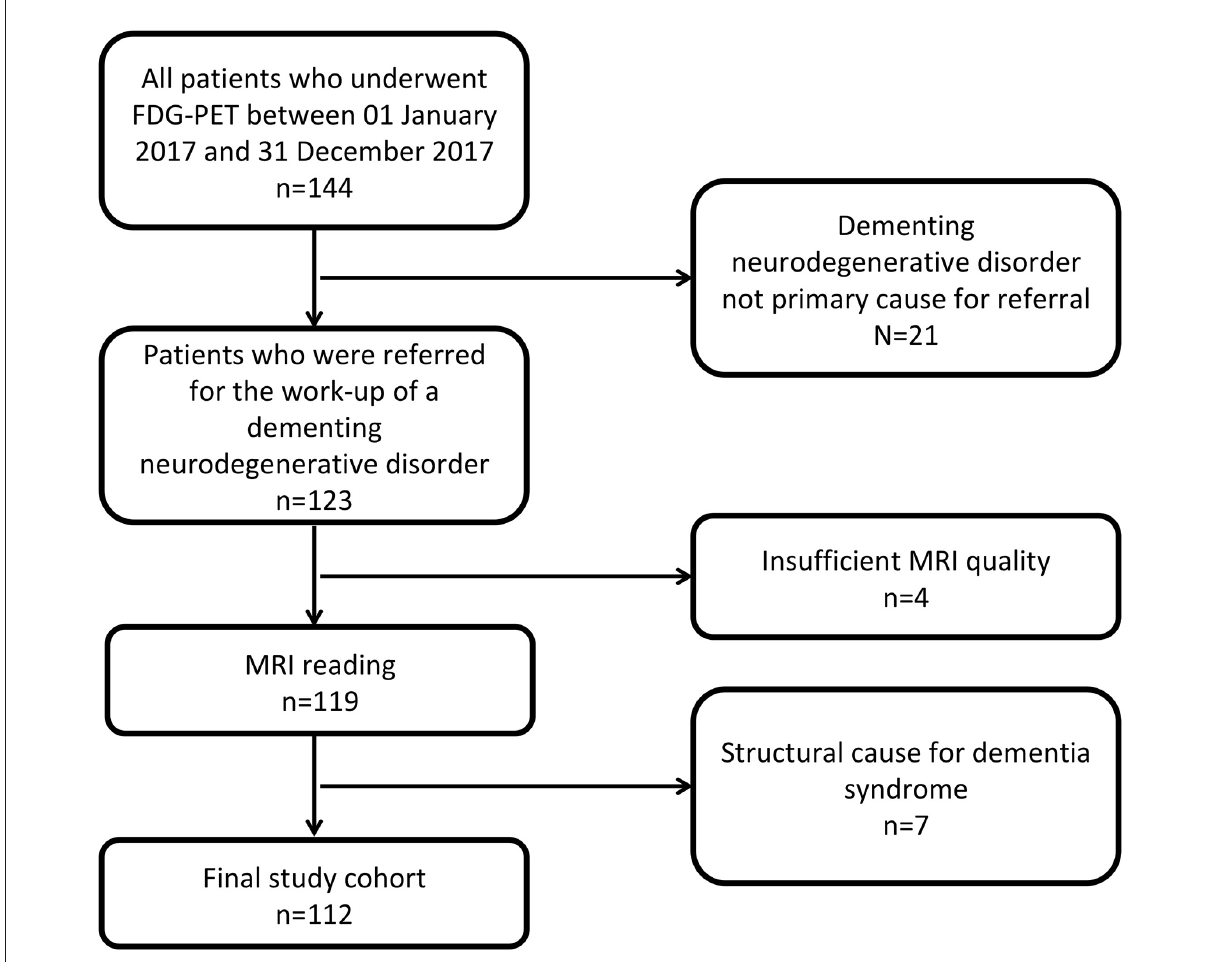
FIGURE1 STARD patient flow diagram after application of exclusion